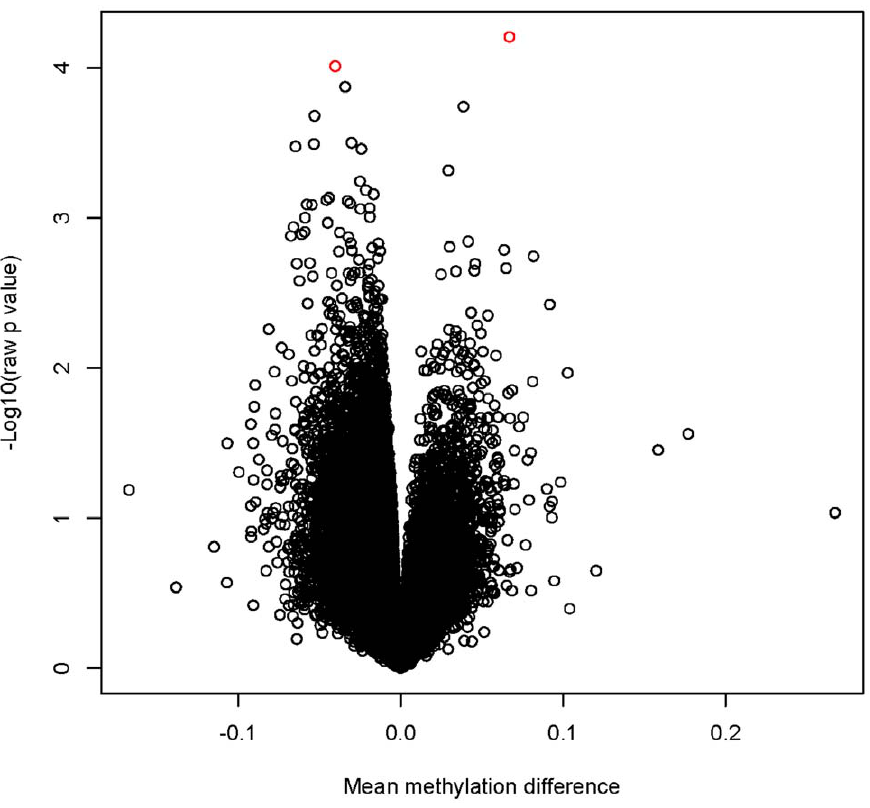
Figure 1. Volcano plot showing raw p values versus mean methylation difference between cases and controls. The two most significant CpG sites are highlighted in red.